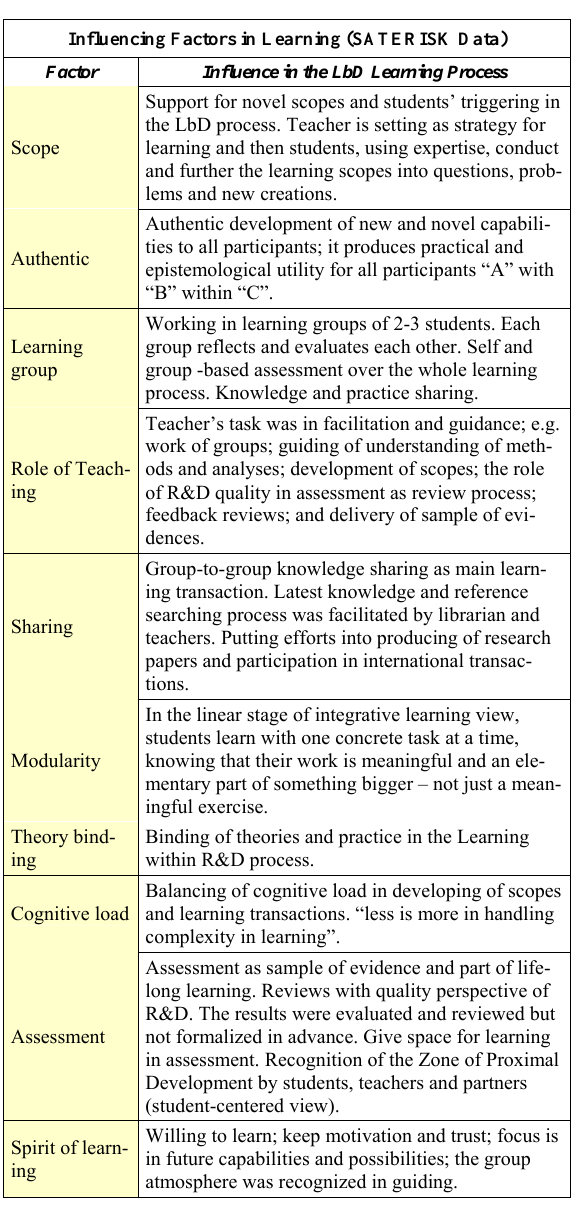
TABLE III. F ACTORS OF L EARNING BY S